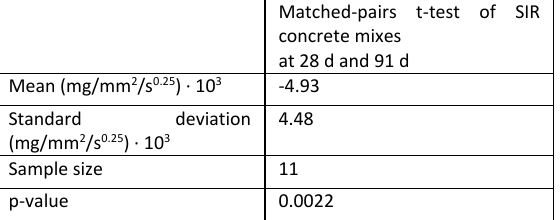
Table 2. Data of the difference in means of the SIR in concrete.